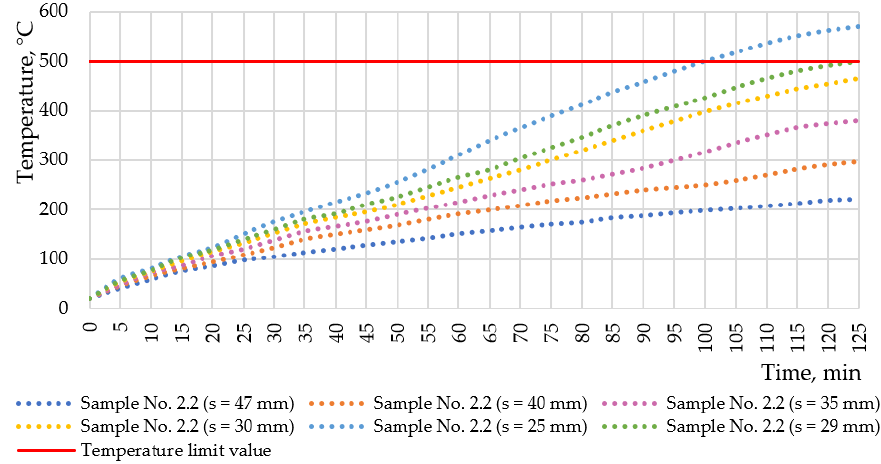
Figure 14. Variations of flame retardant application for sample with coating No. 2.2.